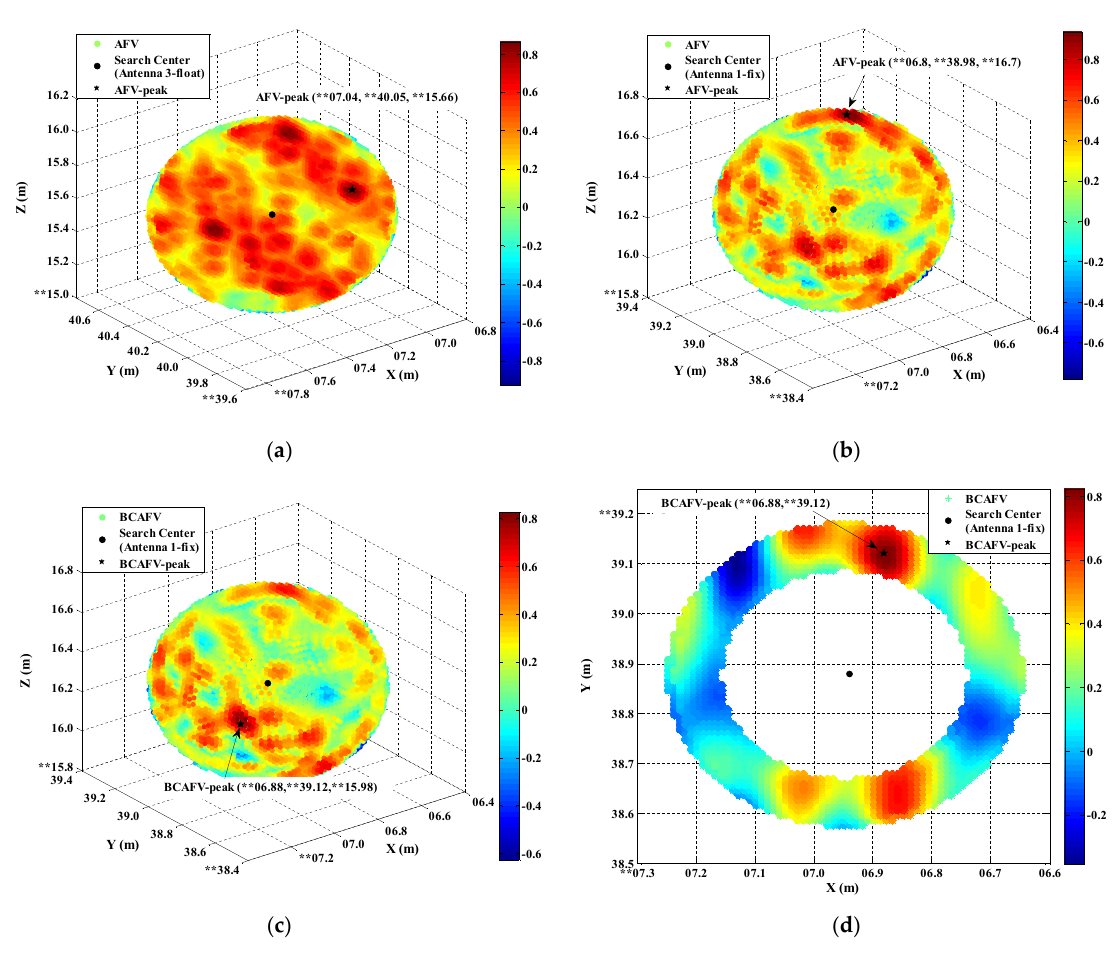
Figure 5. The search candidates of AFM at epoch 03:03:31. ( a ) Search scope of traditional AFM based on the float solution of antenna 3. ( b ) Search scope of AFM based on the fixed solution of antenna 1. ( c ) Search scope of BCAFM. ( d ) The cross section of search scope in ( c ) under the Z coordinate component of peak value. “**” in the figures represents the first few digits in the coordinates what are hidden for the confidentiality of the